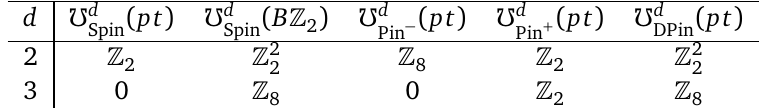
Table 1: Dual bordism groups relevant to our analysis. The first four columns are classic [ 9,27 ] . The last column is